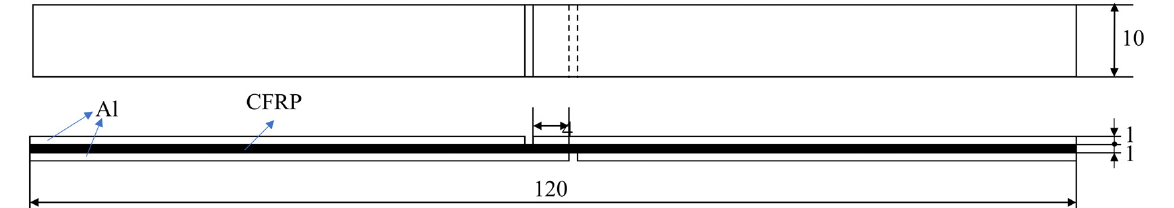
Figure 3. Dimensions of the sheared sample(mm).